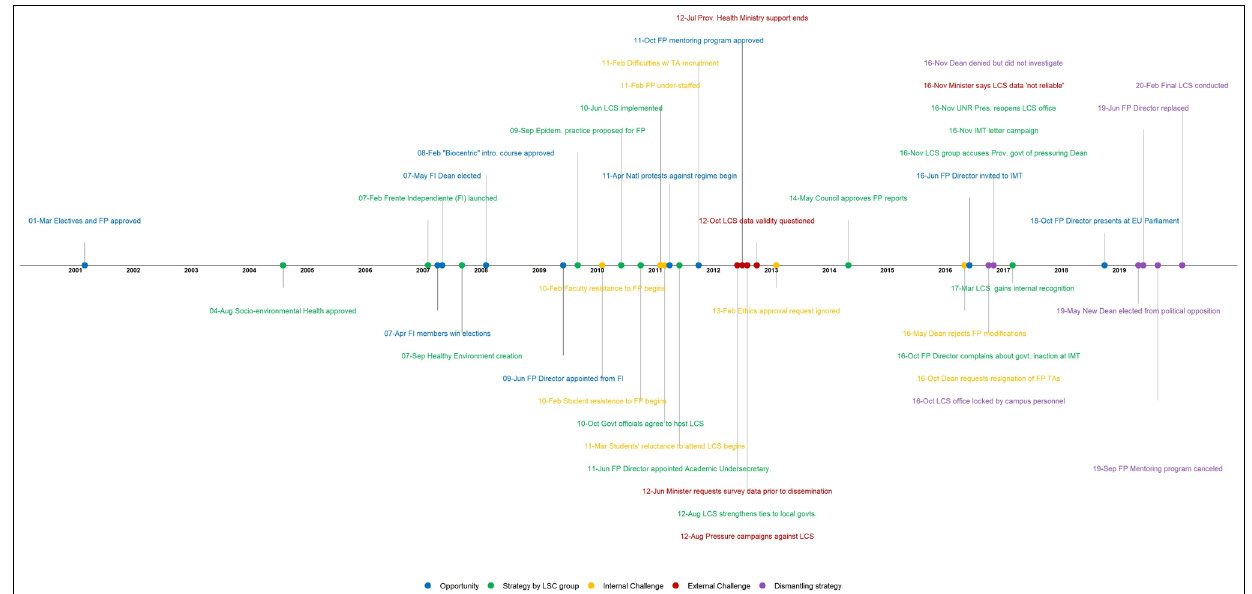
Figure 1 Timeline of events associated with